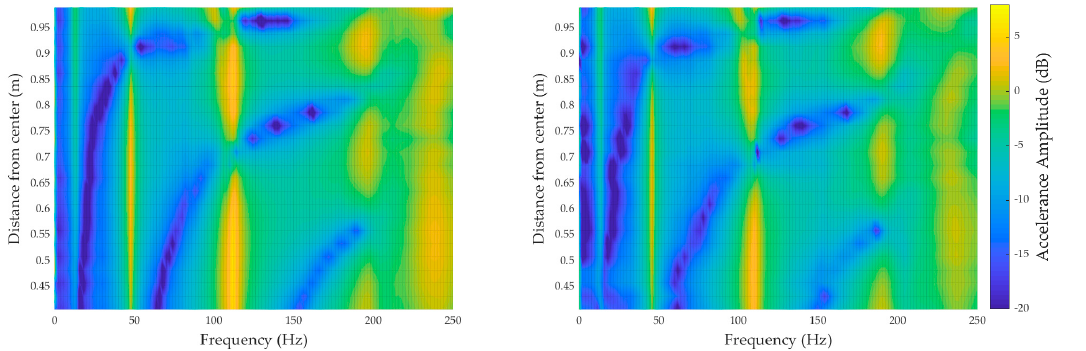
Figure 7. Accelerance maps of an Atomic Redster: ( left ) without the Doubledeck; ( right ) with the